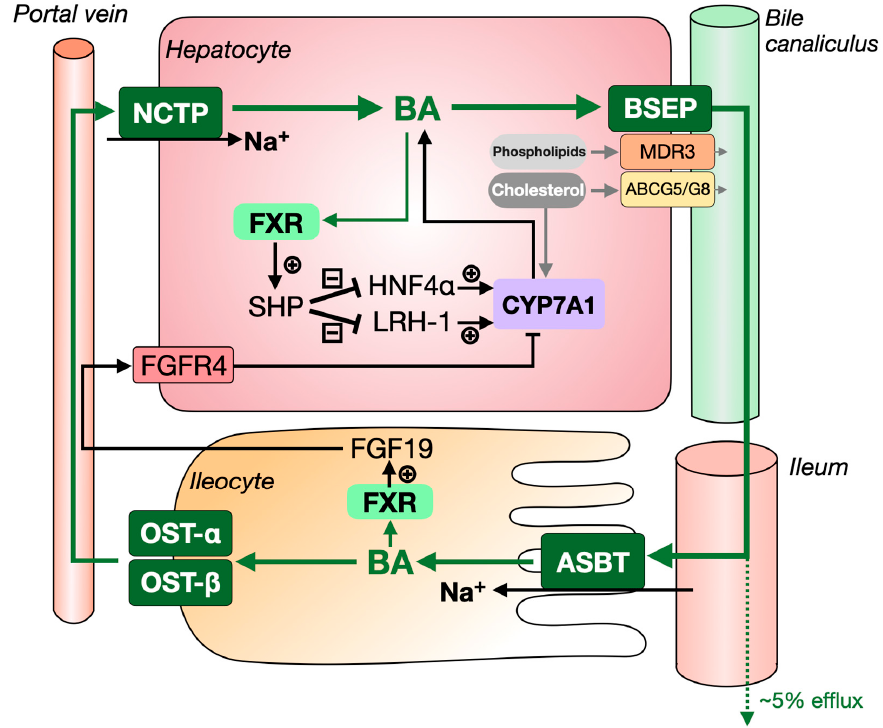
Figure 2. Main transporters of bile acids in the enterohepatic circulation. Once bile acids are synthesized in the liver, they are excreted to the bile canaliculus through the canalicular bile salt export pump, BSEP, and stored in the gall bladder. Phospholipids and cholesterol are transported into the bile by multidrug resistance protein 3 (MDR3) and ATP binding cassette subfamily G member 5/8 (ABCG5/G8), respectively. Bile acids are released into the intestinal lumen upon consumption of a meal to facilitate the digestion and absorption of lipids. In the terminal ileum, approximately 95% of bile acids are reabsorbed, mainly by the apical sodium-dependent bile salt transporter, ASBT. Bile acids are subsequently secreted into the portal circulation by organic solute transporter- α / β , OST- α / β and recycled to the liver, where they are mainly taken up by sodium taurocholate cotransporting polypeptide, NTCP. Bile acids cycle between the liver and intestine ~10 times/day. Each cycle, ~5% of bile acids escapes from reabsorption and is lost in the faeces. Bile acid pool size is maintained by signaling via the farnesoid X receptor (FXR), which induces transcription of its target gene small heterodimer partner ( SHP ). SHP, in turn, inhibits liver receptor homolog 1 (LRH-1) and hepatocyte nuclear factor 4 alpha (HNF4 α ) to reduce the expression of cytochrome P450 family 7 subfamily A member 1 ( CYP7A1 ), encoding the first and rate-controlling enzyme in the major bile acid synthesis pathway. In addition, activation of FXR in the intestine induces expression of fibroblast growth factor 19 (FGF19), which is secreted into the bloodstream and activates the fibroblast growth factor receptor 4 (FGFR4) and its co-receptor β -klotho on hepatocytes, leading to inhibition of CYP7A1 expression via incompletely elucidated